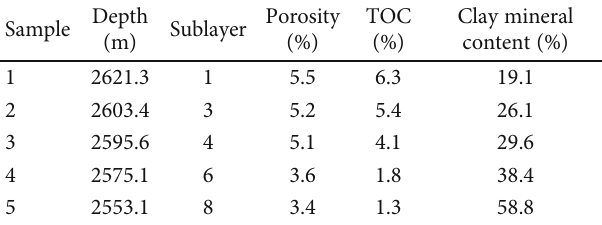
Figure 1: Geographical location of the Fuling shale gas fi eld. Table 1: Basic sample